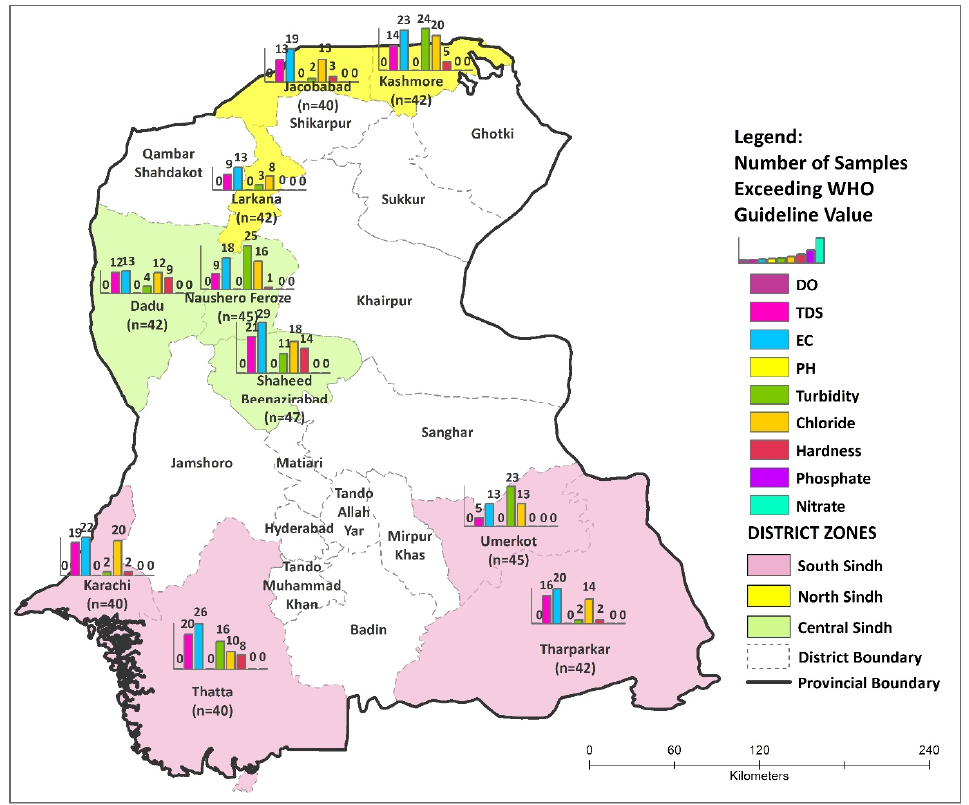
Figure 3. Water quality parameters according to WHO guidelines.